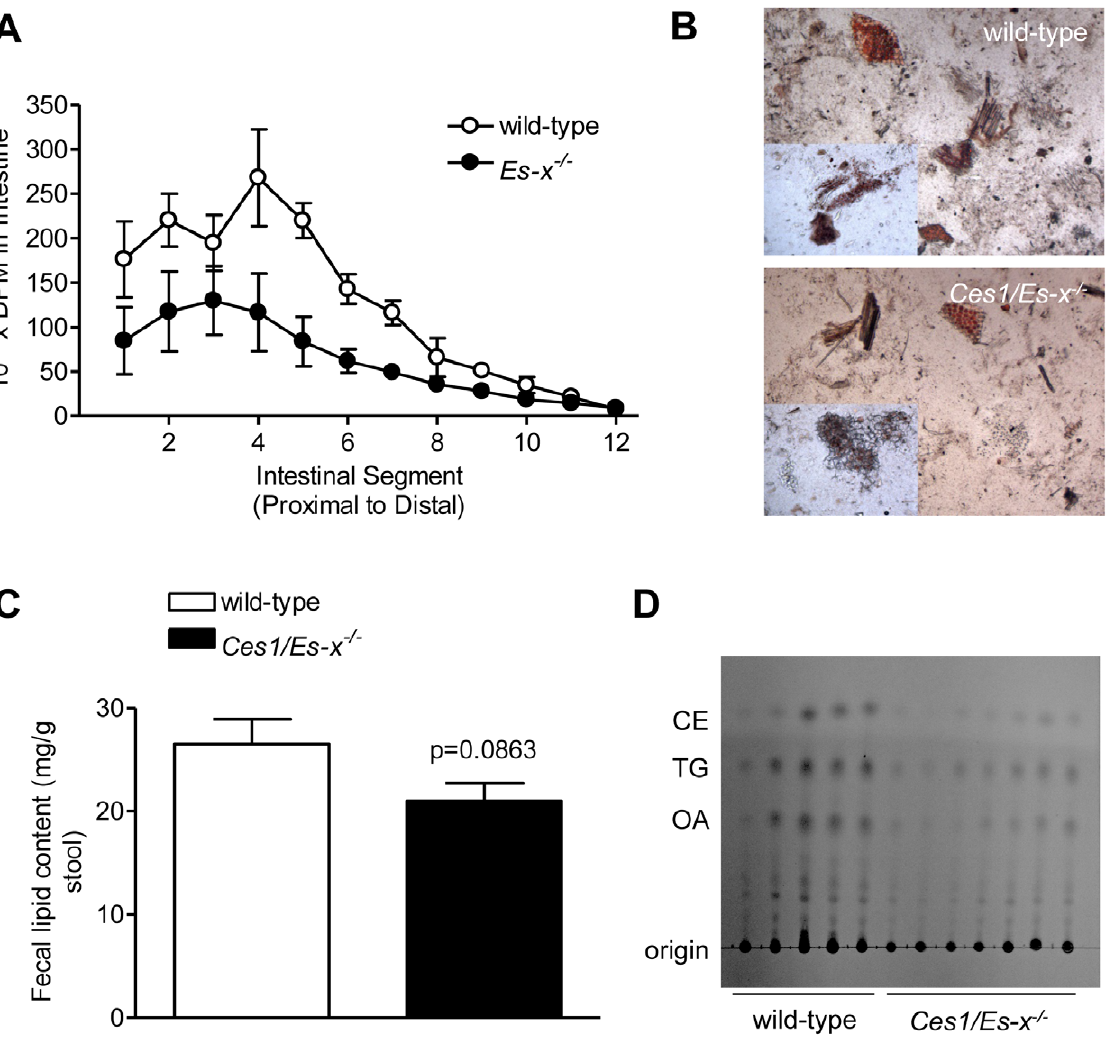
Figure 5. Decreased intestinal TG accumulation and absence of fat malabsorption in Ces1/Es-x 2 / 2 mice. (A) Uptake of dietary fat along the length of the small intestine. Mice were fasted for 4 h and gavaged with radiolabeled triolein diluted in olive oil. Two hours later, the small intestine was excised, flushed, cut, digested and radioactivity associated with the intestinal segments was determined. N=3 mice/group. (B) Fat in stools. Sudan III staining of stool fat upon spontaneous defecation in fed mice. (C) Analysis of fat in stools by organic extraction after spontaneous defecation. N=5–7 mice/group. (D) Fecal lipids analyzed by TLC. N=5–7 mice/group.